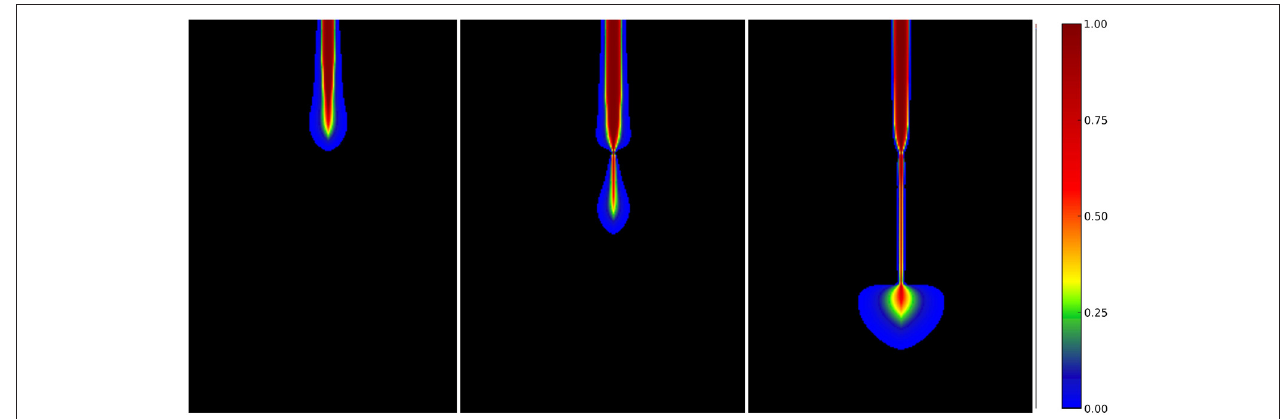
FIGURE 6 | The porosity change, d ˆ φ/ d ˆ t , corresponding to the concentration field in the right panel of Figure 5.